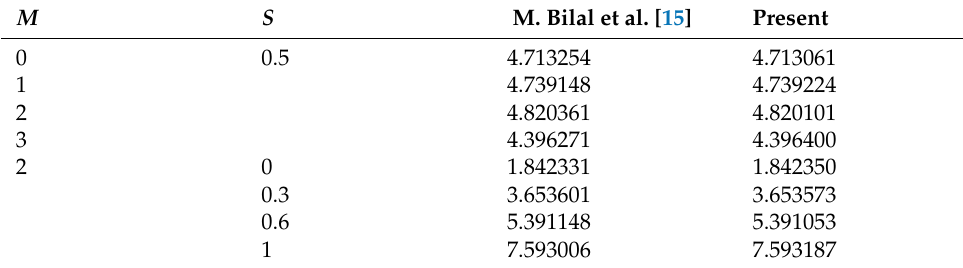
Table 2. Comparison of the numerical results of f (cid:48)(cid:48) ( 1 ) when Φ 1 = Φ 2 = Re m = δ = 0.